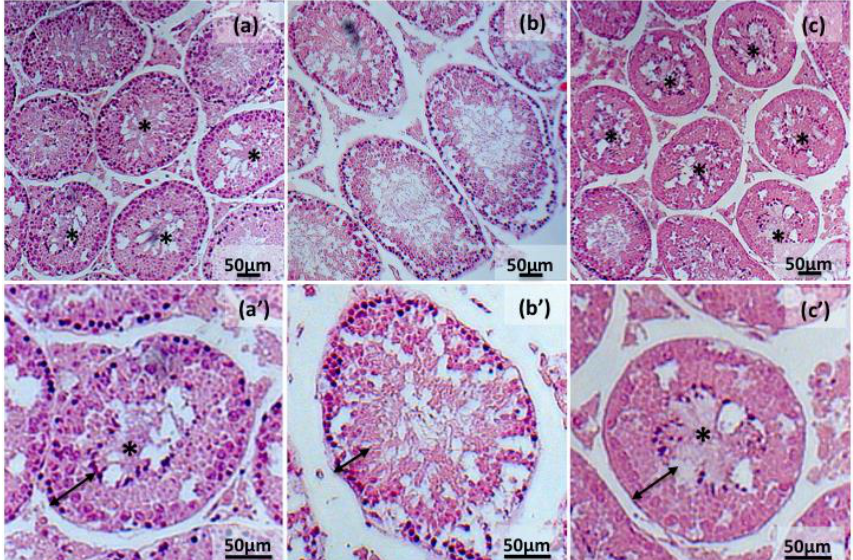
Figure 1. Representative images showing H&E stained testis sections from control ( a , a’ ), irradiated ( b , b’ ) and crocetin + irradiated group ( c , c’ ). Histological features of irradiated testes show a significant increase in diameter and cross-sectional area of seminiferous tubules, a decrease of seminiferous epithelium height compared with the control group. Crocetin pretreatment significantly protects irradiated testes from X-rays injury. Seminiferous epithelium height is delimited by black double arrow. Mature spermatozoa located into the lumen of tubules are indicated with asterisk.